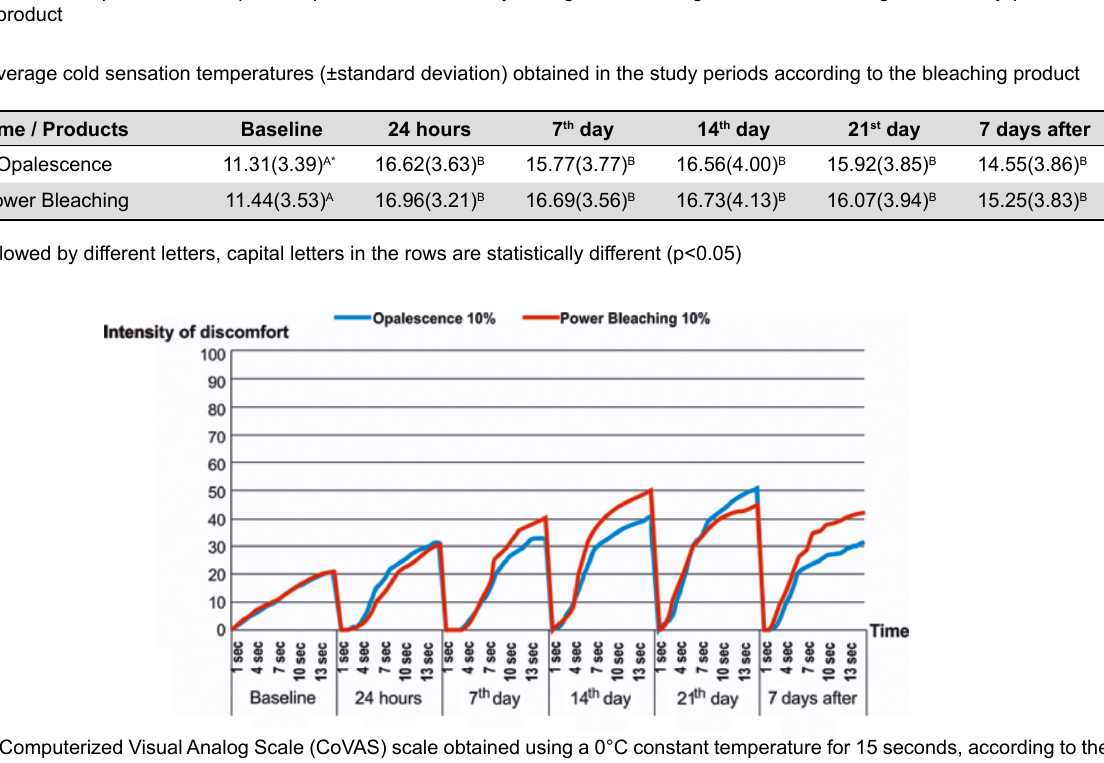
Figure 5- Computerized Visual Analog Scale (CoVAS) scale obtained using a 0°C constant temperature for 15 seconds, according to the study periods and bleaching